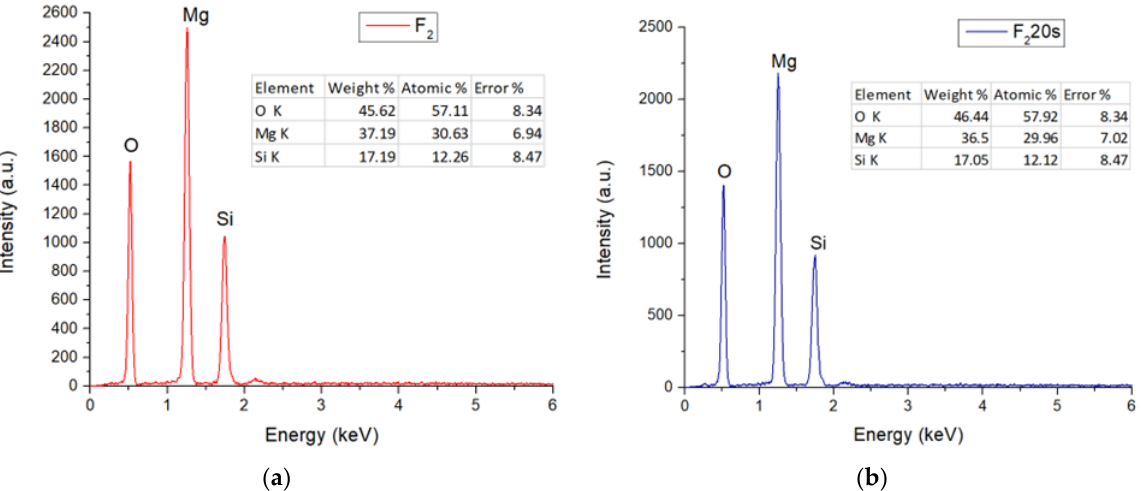
Figure 6. EDS spectra for F 2 ( a ) and F 2 20s ( b ) samples.